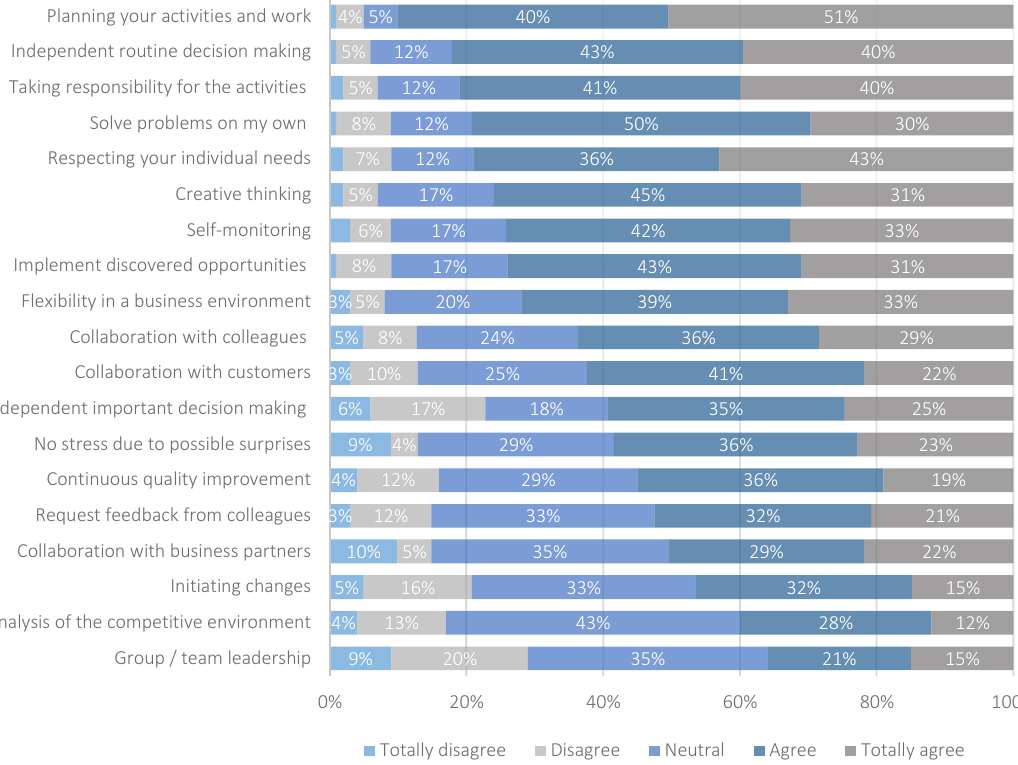
Figure 1. Assessing self-organization components mostly used in remote